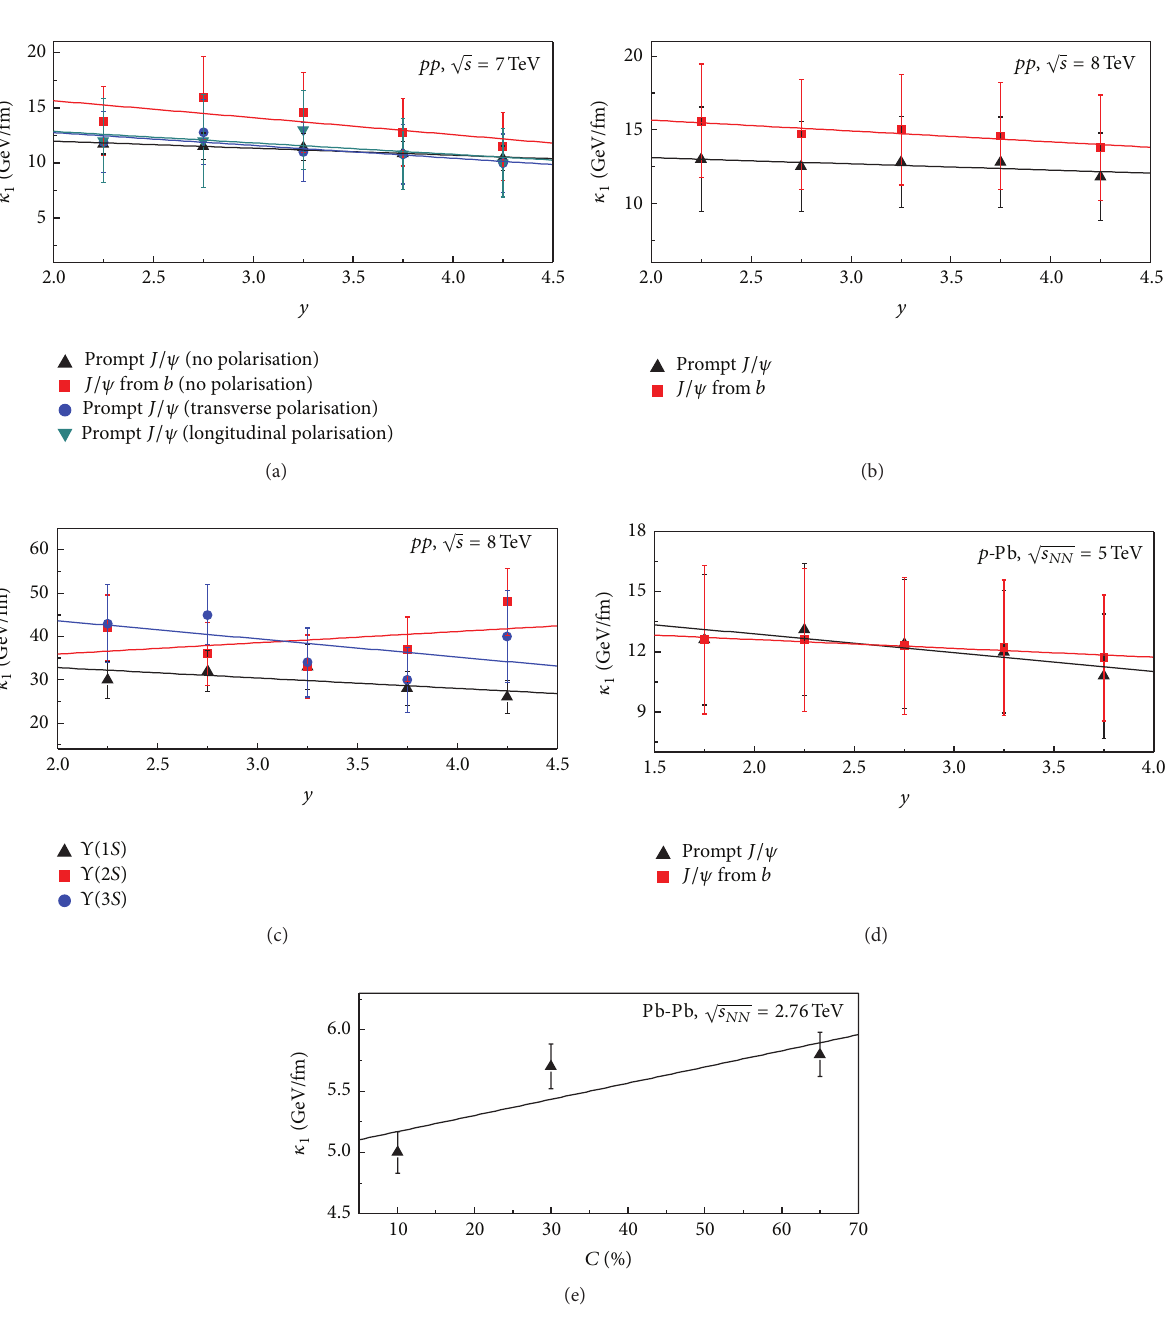
Figure 10: The same as Figure 6 but showing the results for 𝜅 1